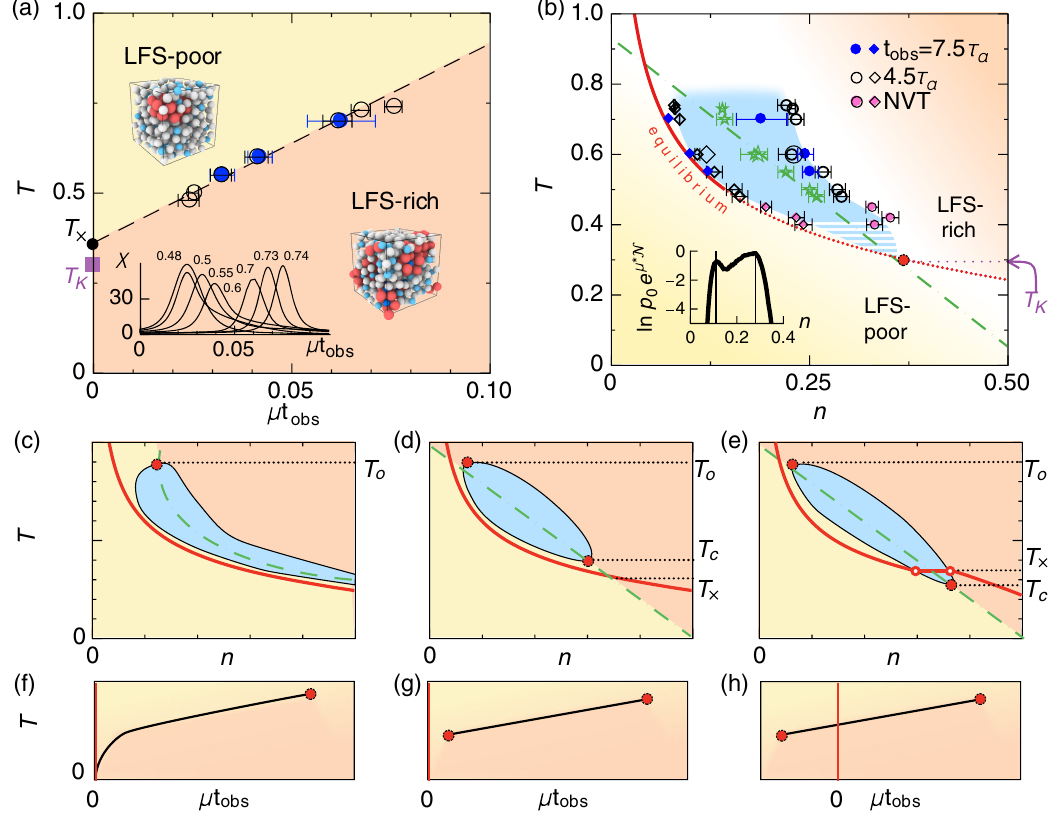
FIG. 4. Phase diagram for the dynamical transition and possible scenarios for a lower critical point. (a) Coexistence in the T − μ phase μ → 0 Þ ¼ 0 . 37 (black dot) close to T 0 . 30 (purple diagram, with μ scaled by the trajectory length. Linear extrapolation implies T K ¼ × ð (cid:4) (cid:4) square). Inset: Susceptibilities χ of the LFS population labeled by their sampling temperatures for a system for N ¼ 216 and 4 . 5 τ t α , showing a nonmonotonic behavior with increasing peak heights at low and high temperatures. Two snapshots of LFS-rich obs ¼ and LFS-poor configurations are also illustrated, with the non-LFS particles in white and pale blue. (b) Coexisting populations for ≈ 7 . 5 τ ≈ 4 . 5 τ 400 N ¼ 216 particles and several sampling temperatures (filled symbols show t α ; empty symbols show t obs α ) and N ¼ obs 0 . 6 (larger empty symbols). Green stars denote n at T fitted to a linear function (dashed-dotted green line). ð T Þ ¼ h n i s ¼ (cid:4) T; μ (cid:4) Additionally, coexisting populations at temperatures lower than T ¼ 0 . 48 are obtained from nonequilibrium molecular dynamics at constant temperature (NVT) with LFS-rich initial conditions, as discussed in Appendix. A possible coexistence region is sketched (shaded area). The unbiased equilibrium dynamics [red continuous line, Eq. (2)] passes through the supercooled, LFS-poor liquid. We show the scenario of a lower critical point of the dynamical transition at T passed by the unbiased dynamics at a crossing temperature c ≈ T ≈ T T with T . Inset: Example for the determination of the coexisting LFS populations from the peak positions of histograms K c × × 0 . 60 and t 4 . 5 τ – e) are sketches for alternative scenarios, with panels (f – h) p ð n Þ evaluated at μ ¼ μ for T α . Finally, panels (c s ¼ obs ¼ (cid:4) being their counterpart in the T − μ space: In panels (c,f), the coexistence region extends down to T ¼ 0 ; in (d,g), two critical points bound the coexistence region with the equilibrium line approaching the lower critical point in an “ avoided transition ” scenario; and in (e,h), the liquid undergoes a weakly first-order transition at low temperature. At the onset temperature T and above, dynamical o heterogeneities vanish, and in its vicinity, we schematically locate an upper critical point bounding the coexistence